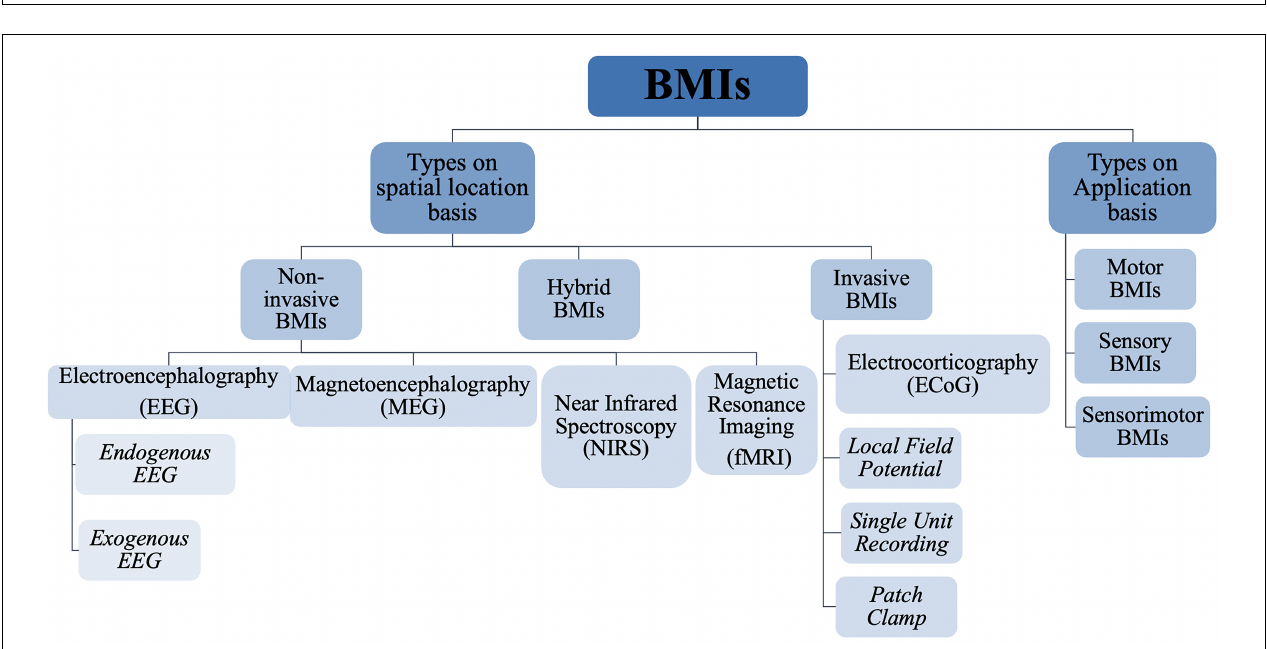
FIGURE 6 | Signal acquisition techniques and challenges. (A) Invasive vs. non-invasive BMI techniques; (B) electrode buckling upon intracortical insertion; (C) damage to electrode due to corrosion, passivation layer degradation, and mechanical mismatch.